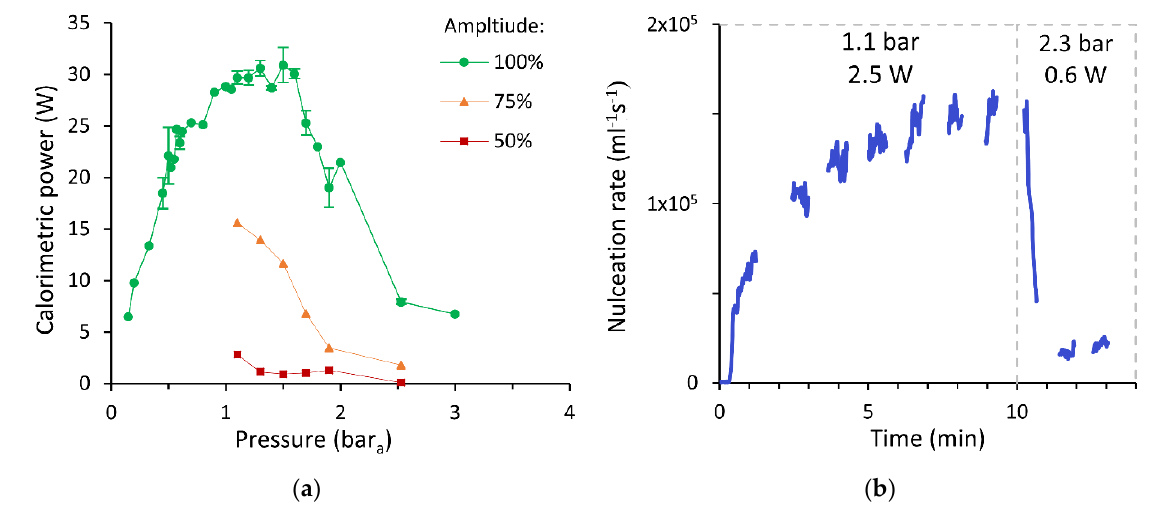
Figure 8. ( a ) Influence of the static pressure on the calorimetric ultrasonic power at different ultrasonic amplitudes. Error bars indicate the standard deviation on multiple measurements; ( b ) Nucleation rate experiment where the static pressure in the ultrasonic nucleator was adjusted to 2.2 bar after 10 min.